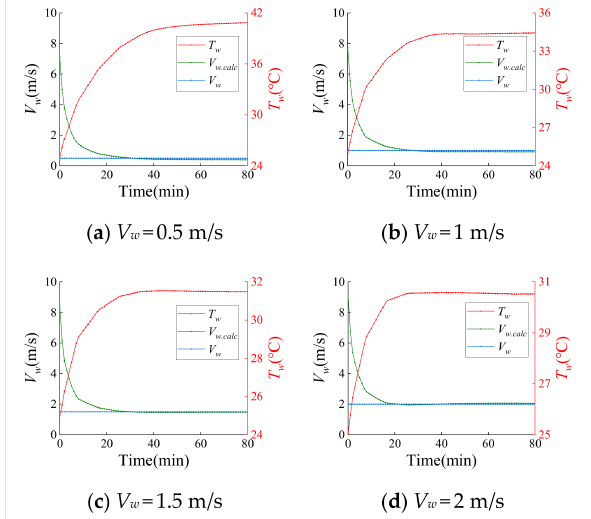
Figure 12. Comparison between the equivalent wind speeds calculated by EHT model and input wind speeds.